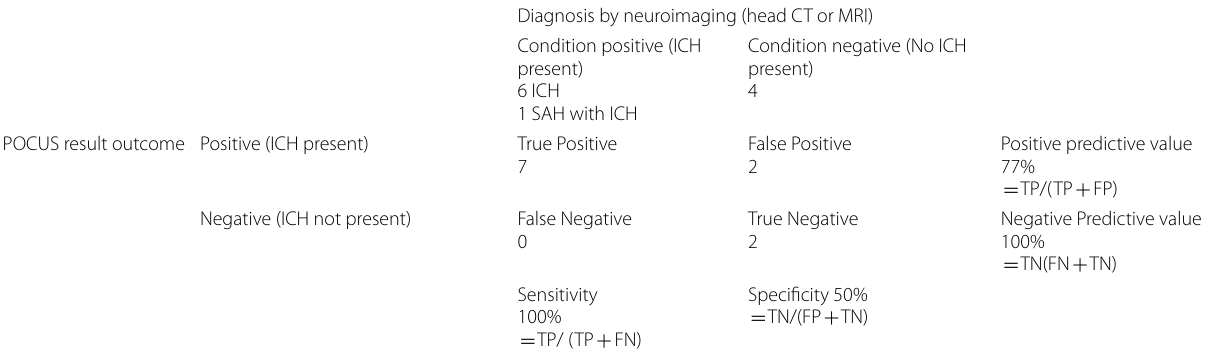
Table 3 Results of blinded investigator-based diagnosis using POCUS compared to patient